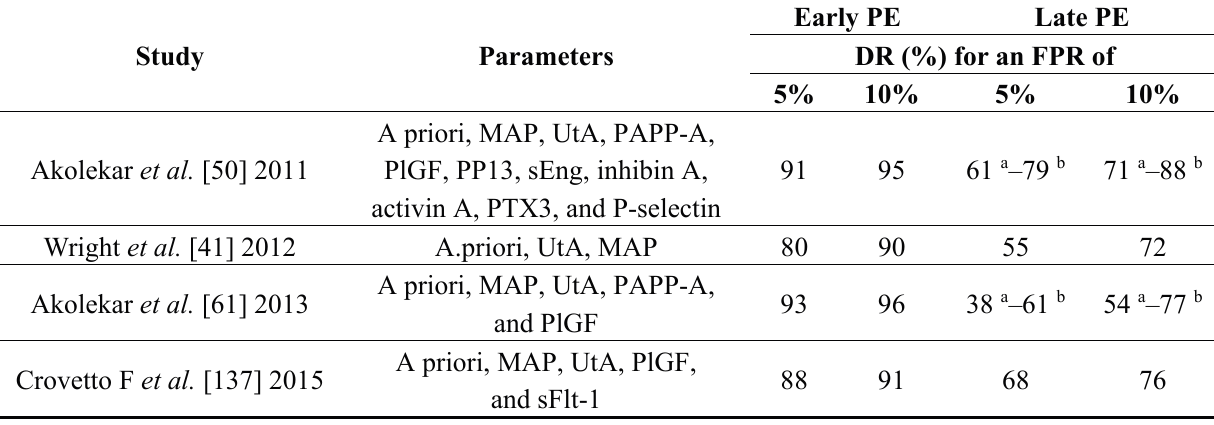
Table 1. Algorithms for the prediction of early and late